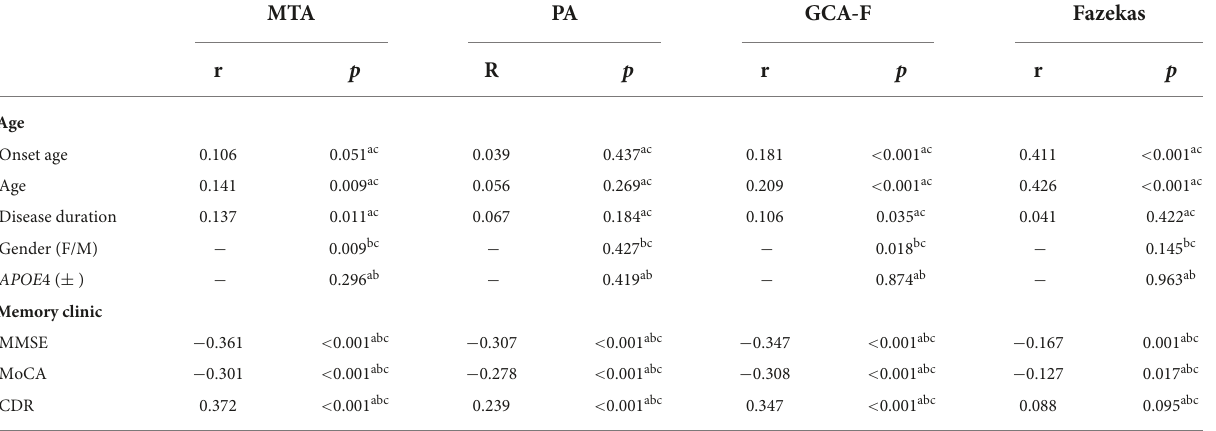
TABLE 2 Correlation analysis between each visual rating scale and AD